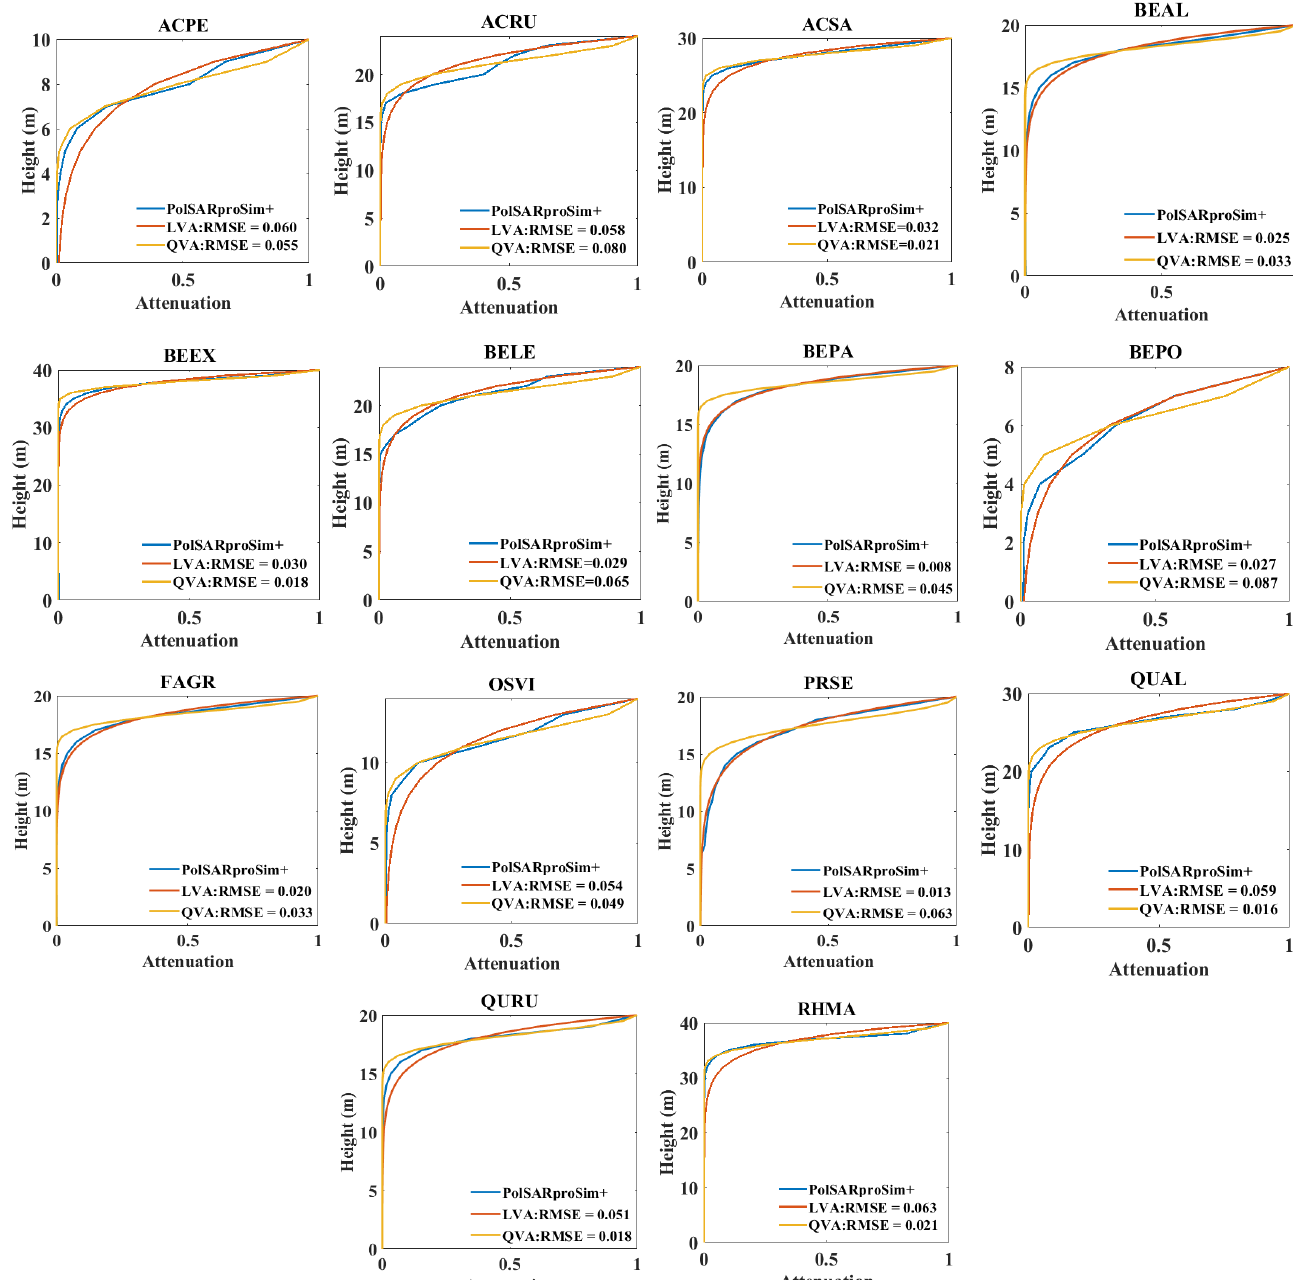
Figure 7. Vertical scattering attenuation fitting results of the deciduous forest stands (see Table 1 for an explanation of the acronyms).